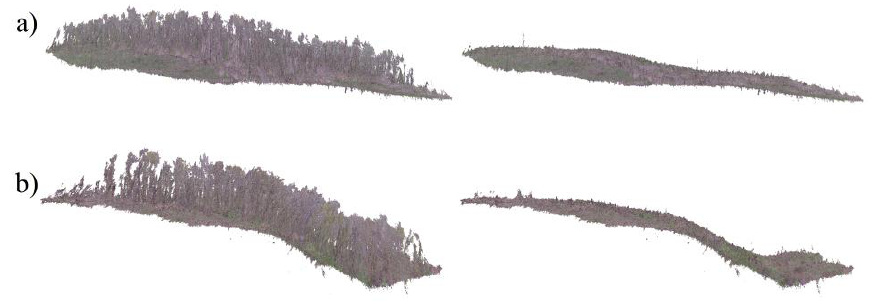
Figure 4. Comparison of point clouds in ( a ) Area 1 and ( b ) Area 2 before (left) and after (right) classification and removal of non-ground points with MCC-LIDAR.